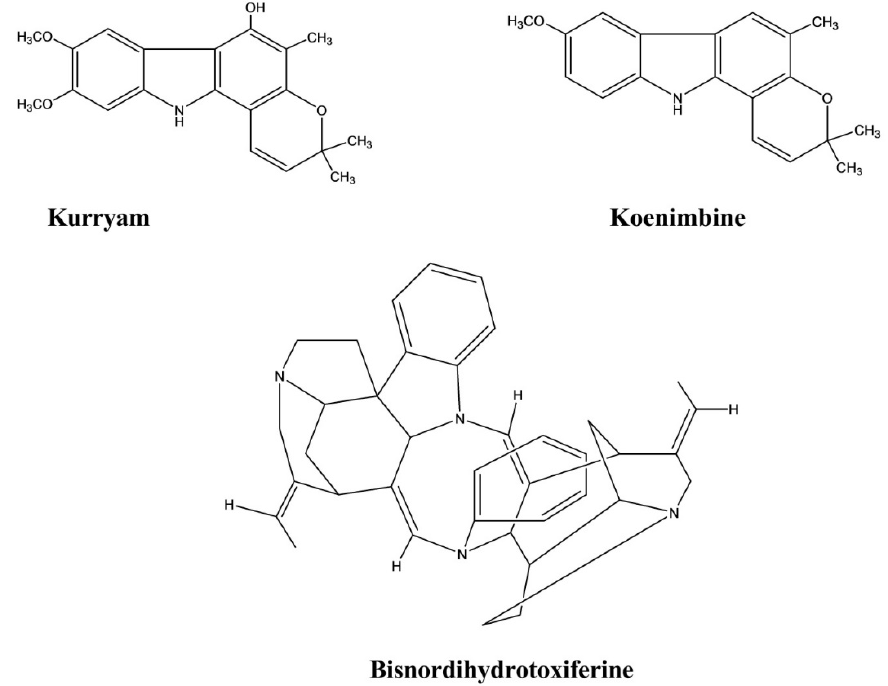
Figure 14. Antidiarrheal activity of indole